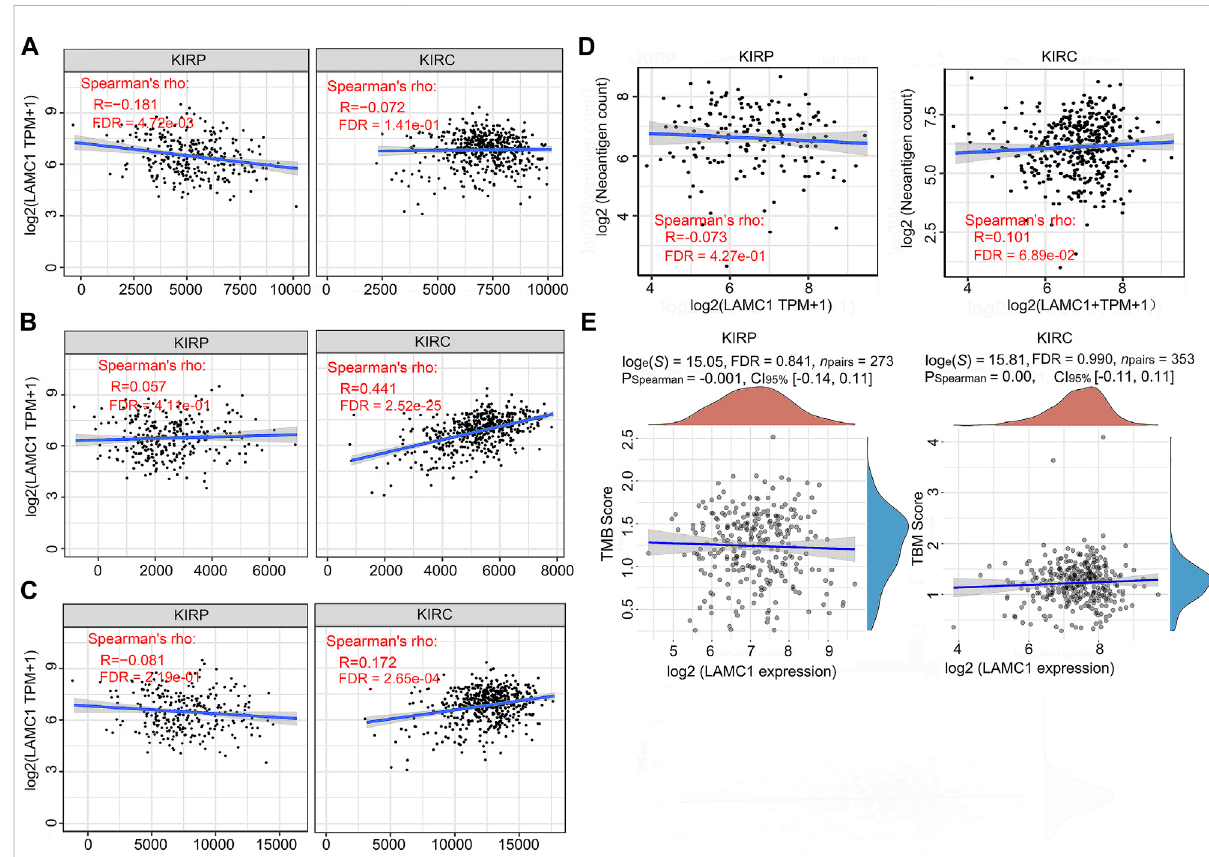
FIGURE 8 The relationships between LAMC1 expression and tumor immune microenvironment, neoantigens appearance and TMB. (A) Correlation analysis between LAMC1 expression and immune scores in KIRP and KIRC. (B) Correlation analysis between LAMC1 expression and stromal scores in KIRP and KIRC. (C) Correlation analysis between LAMC1 expression and estimate immune scores in KIRP and KIRC. (D) Correlation analysis between LAMC1 expressionandthenumberofneoantigensinKIRPandKIRC. (E) Correlationanalysisbetween LAMC1 expressionandTMBscoresinKIRP and KIRC. TMB, Tumor mutational